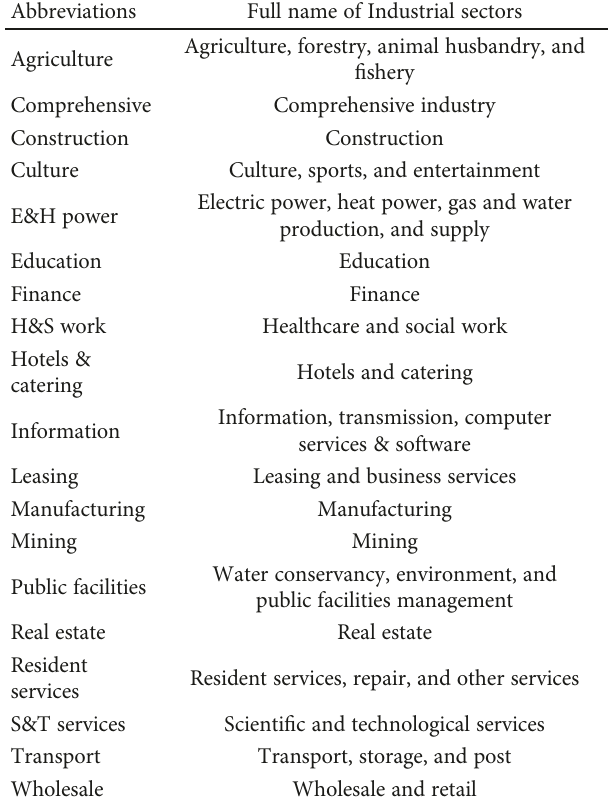
Table 1: Industrial sectors ’